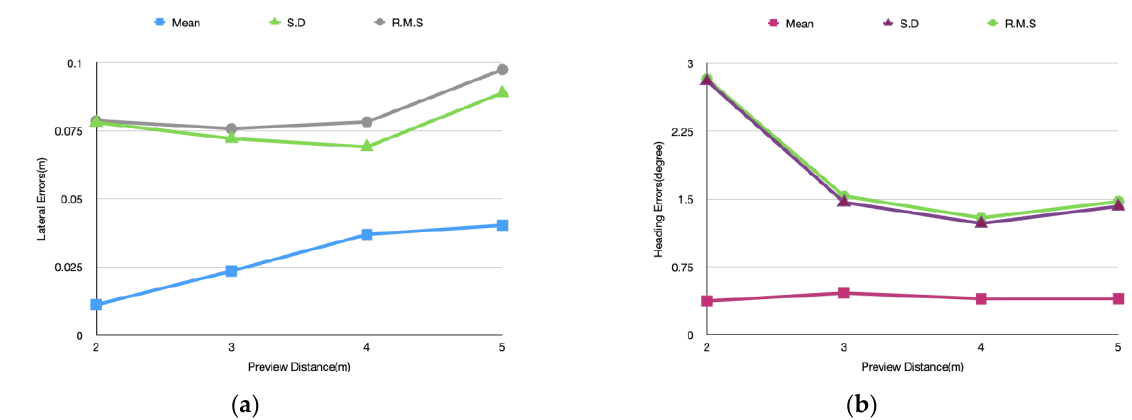
Figure 8. Posture adjustment performance. ( a ) Lateral errors; ( b ) heading errors.